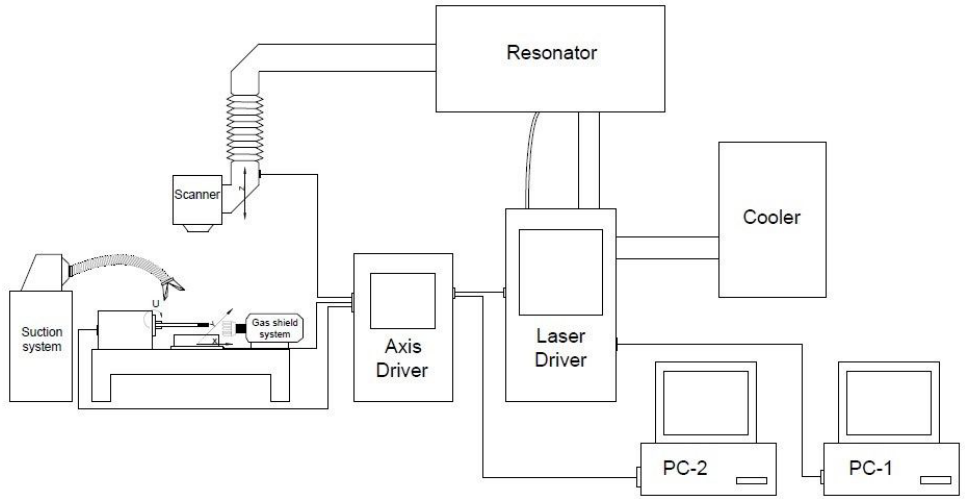
Figure 1: The scheme of the test stand with TruMicro 5325c laser.